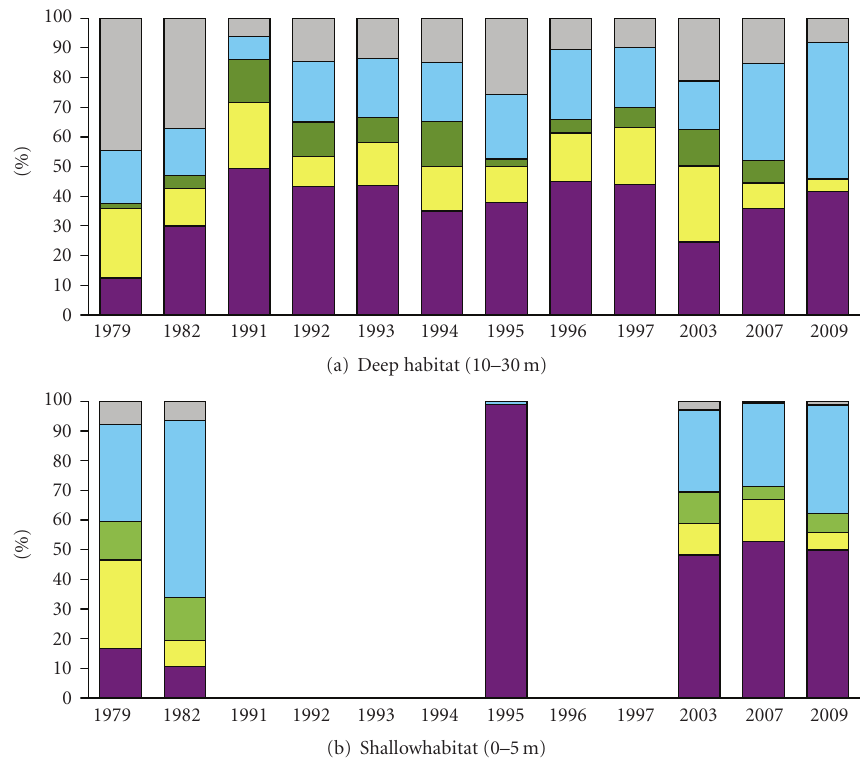
Figure 6: Interannual variation in relative abundance of major coral genera at Tiahura reef, Moorea